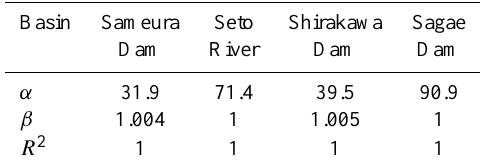
Table 3. Optimum values of parameters α and β , and the correlation coefficient R 2 .